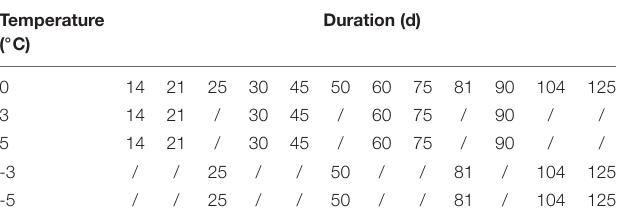
TABLE 1 | Duration of seedlings stored at different temperatures. Temperature ( ◦